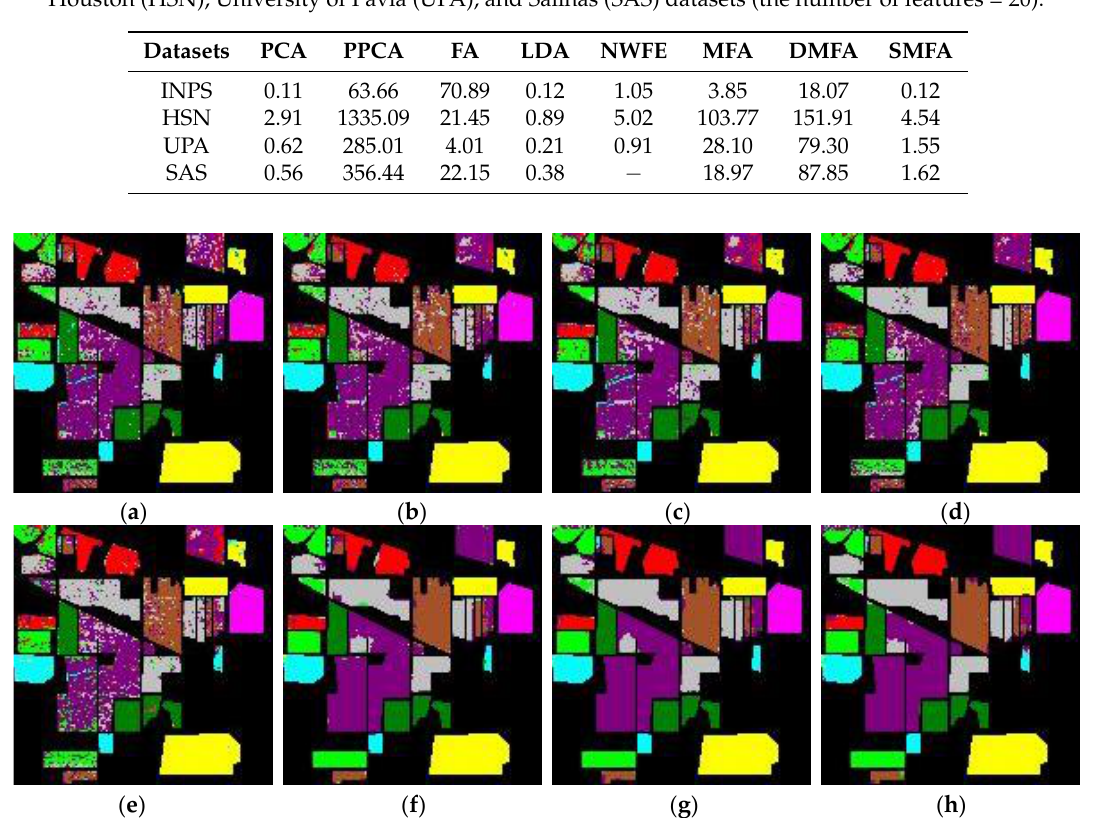
Figure 10. Classification maps for the Indian Pines dataset obtained by SVM classification after using ( a ) PCA, ( b ) PPCA, ( c ) FA, ( d ) LDA, ( e ) NWFE, ( f ) MFA, ( g ) DMFA, and ( h ) SMFA DR